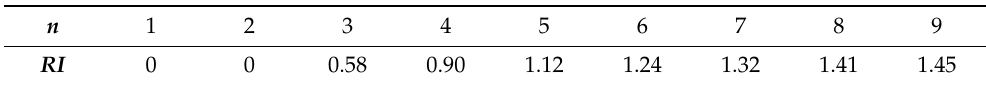
Table 2. RI value.